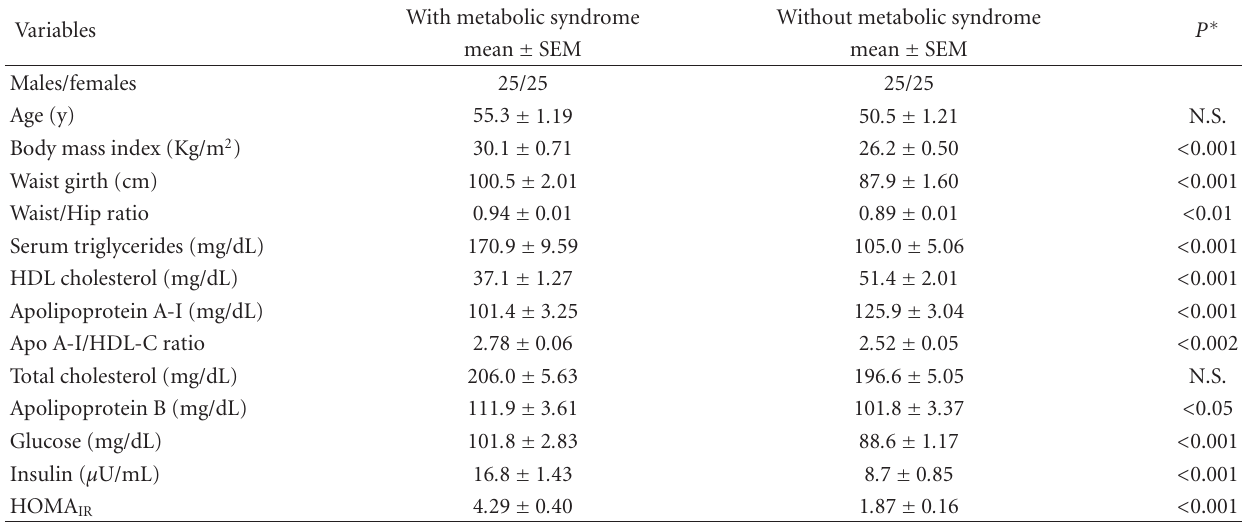
Table 1: Physical characteristics and fasting metabolic profile of the patients included in the study.